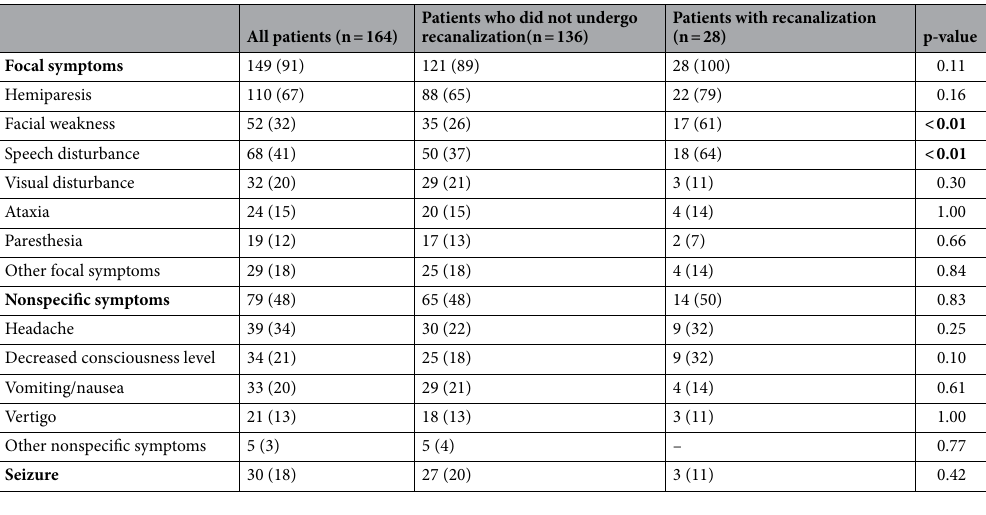
Table 3. Presenting symptoms. Variables are expressed as n (%); p-values from x 2 test or Fisher’s exact test comparing symptoms of patients with RT and symptoms of patients with non-RT. Presenting symptoms for the whole group (n = 164) and divided by therapy.